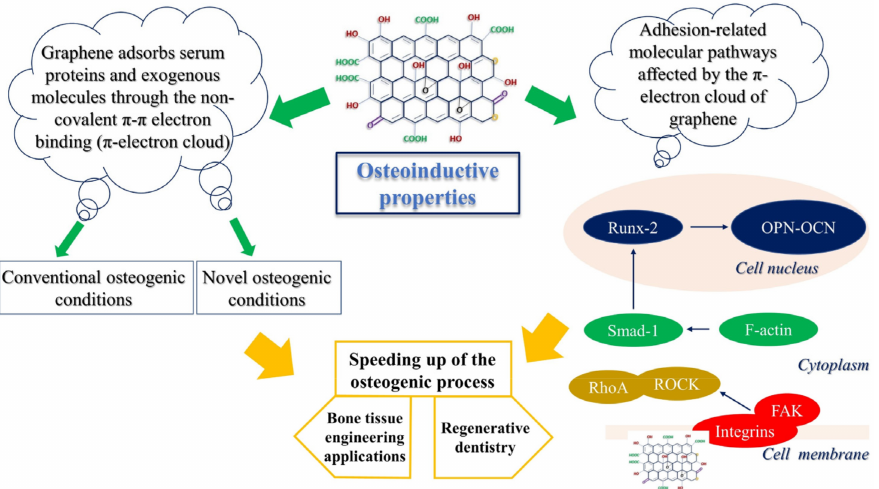
Figure 3. Osteoinductive properties of GO. Graphene enhances the osteogenic process by inter- acting with biomacromolecules through its π -electron cloud. In addition, GO is able to trigger cell-adhesion-related molecular pathways. FAK = focal adhesion kinase; SMAD1 = small mothers against decapentaplegic-1; ROCK = Rho-associated protein kinase; RhoA = Ras homologous GTPase; RUNX2 = runt-related transcription factor 2; OPN = osteopontin; OCN =